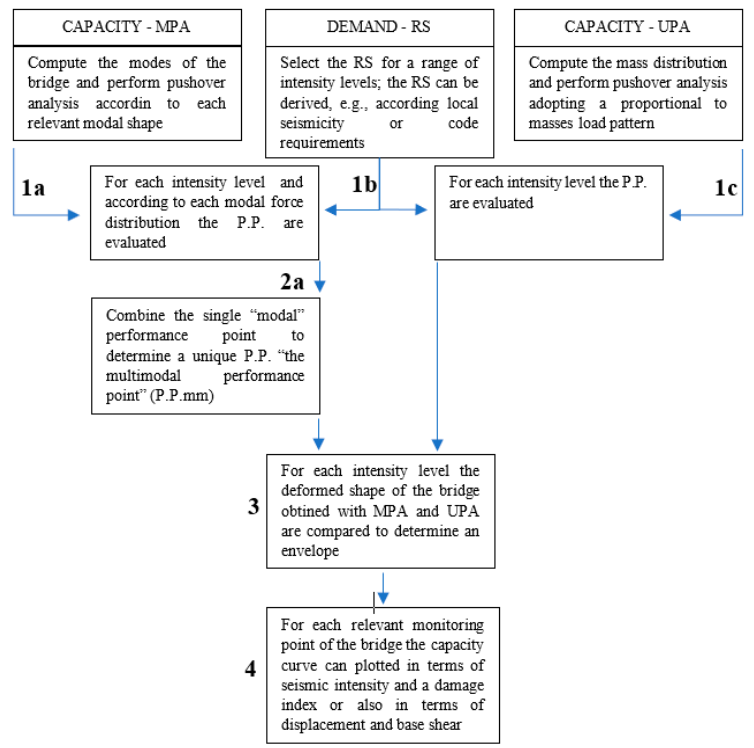
Figure 19. Flowchart of IMPA β procedure for nonlinear static analysis of bridges.